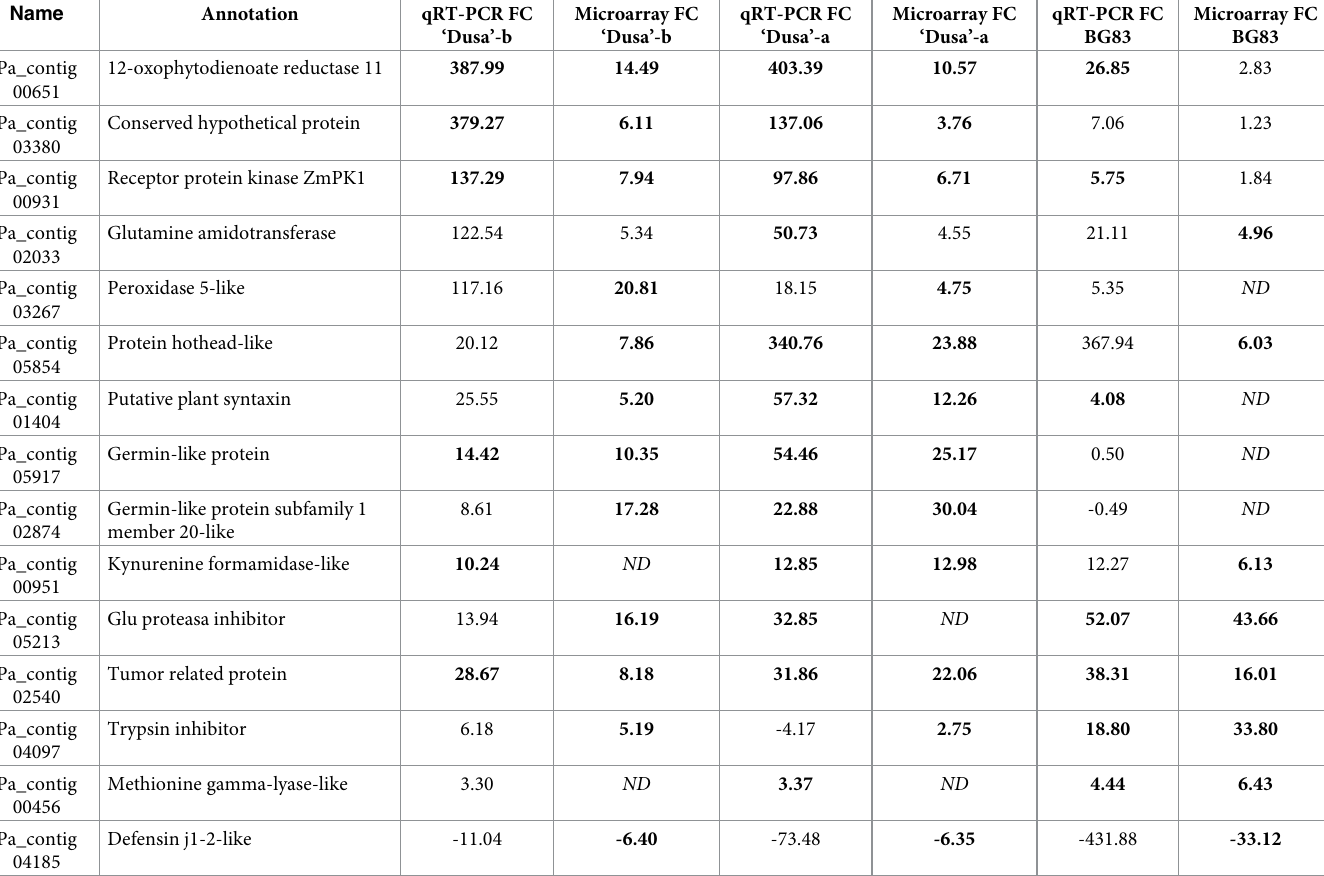
Table 1. qRT-PCR and microarray expression data of selected contigs from susceptible ‘Dusa’-b, ‘Dusa’-a and tolerant BG83 avocado rootstocks infected with R . necatrix .